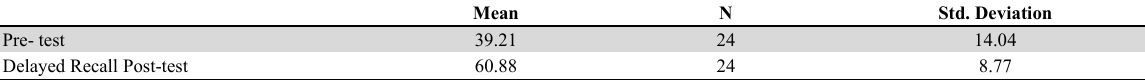
Mean N Std. Deviation